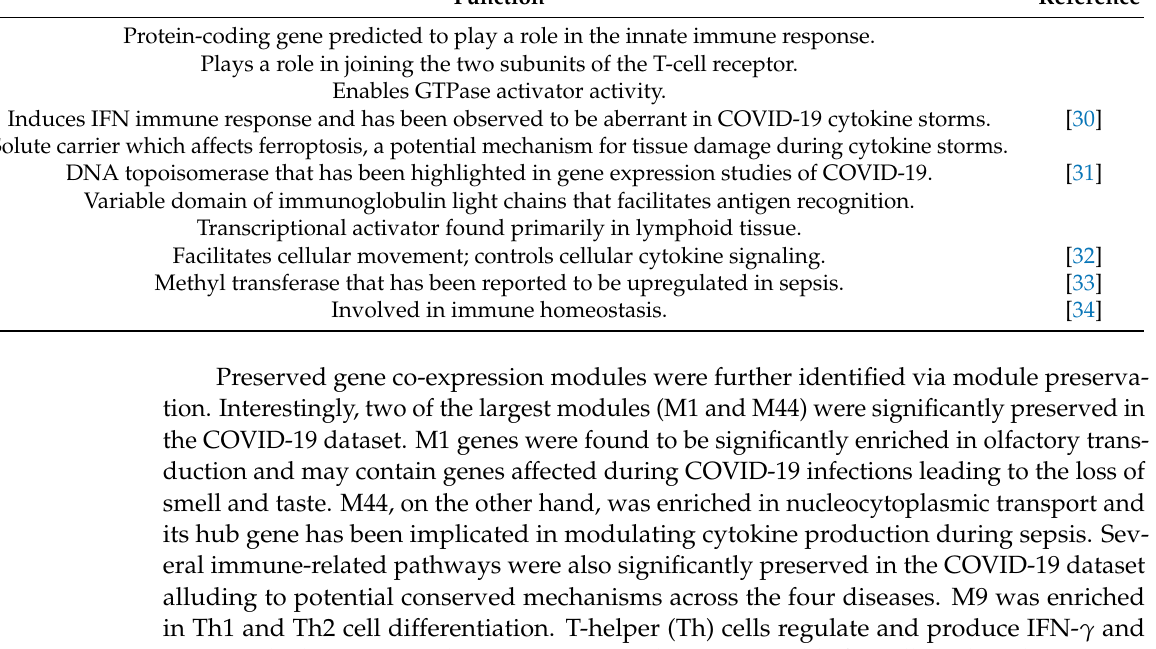
Table 4. Hub genes and their corresponding functions screened via intramodular connectivity. Hub Gene Function